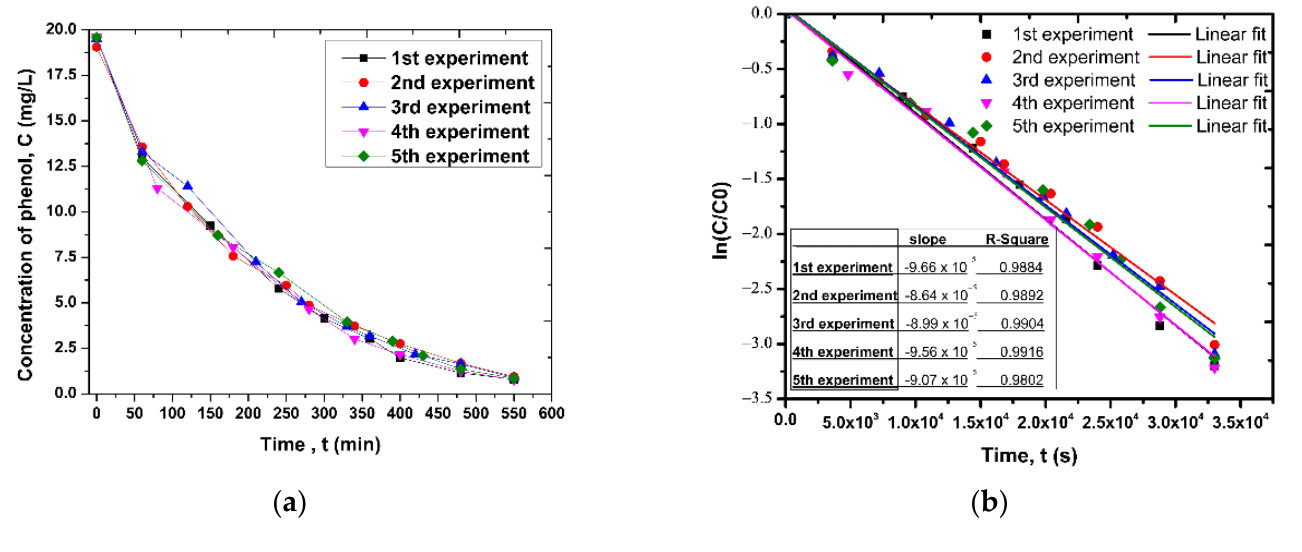
Figure 14. ( a ) Phenol concentration in recycle tank as a function of time for five cycles of photoca- talysis, performed on a STST reactor with the same pack of ZnO-coated Dnit balls. ( b ) Calculation of the slope of the curves.